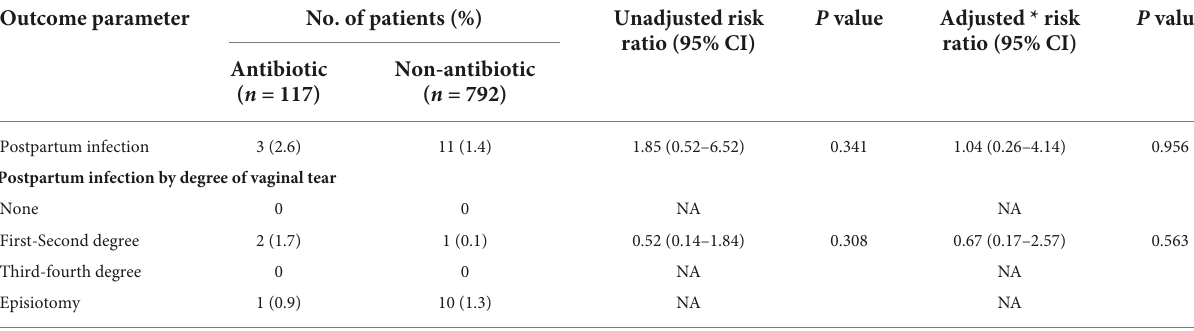
TABLE 2 Incidence rates of postpartum infections by antibiotic prophylaxis